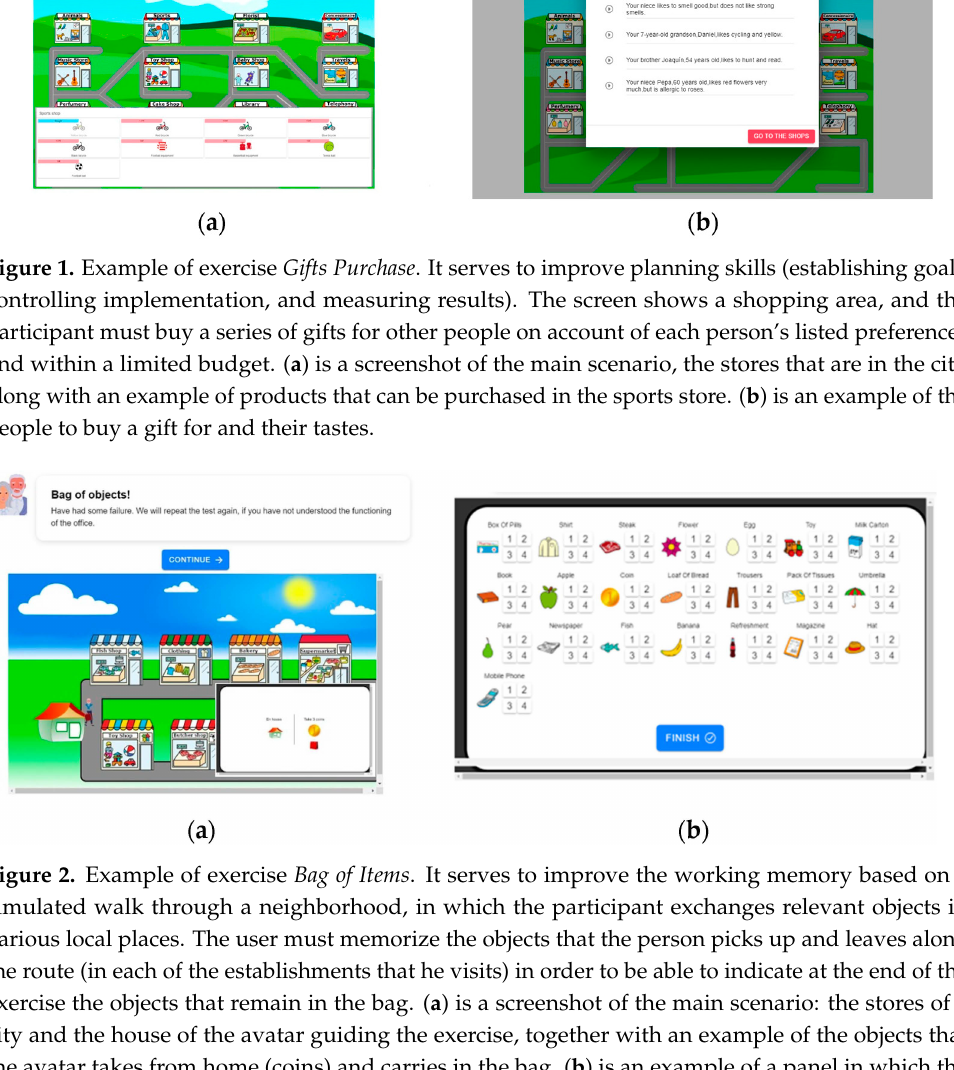
Figure 2. Example of exercise Bag of Items . It serves to improve the working memory based on a simulated walk through a neighborhood, in which the participant exchanges relevant objects in